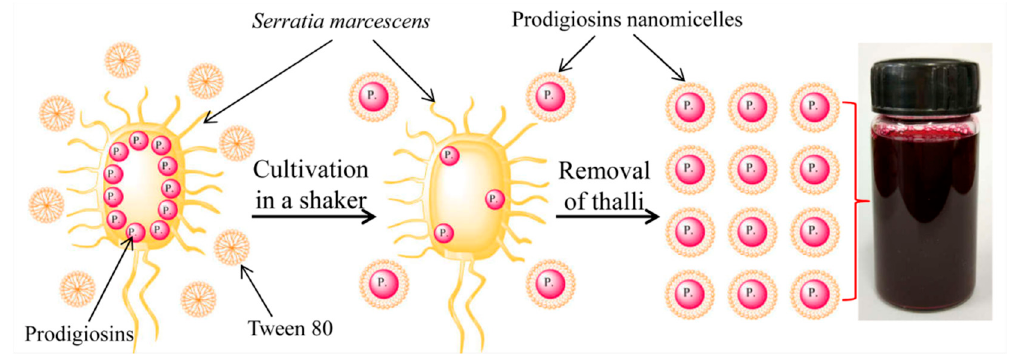
Figure 2. Preparation of prodigiosins nanosuspension.